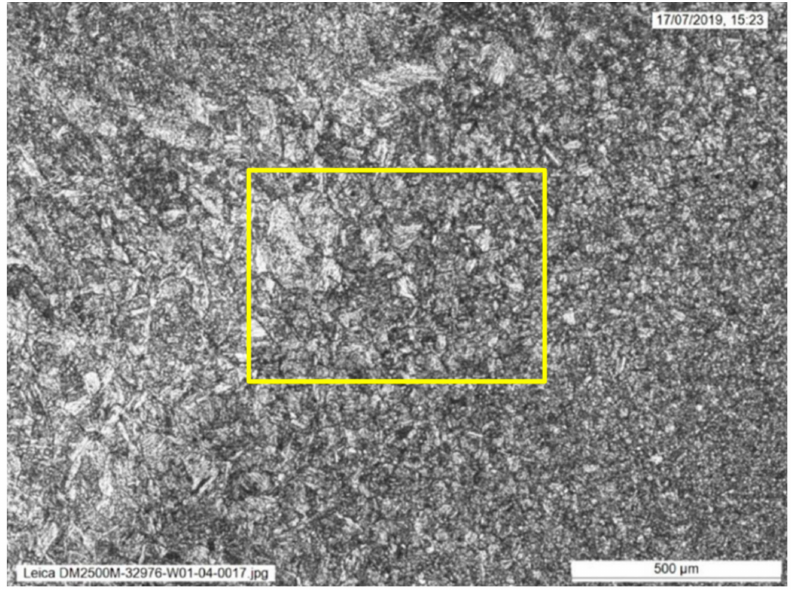
Figure 3. Microstructure in the location of the ICGCHAZ identified in Figure